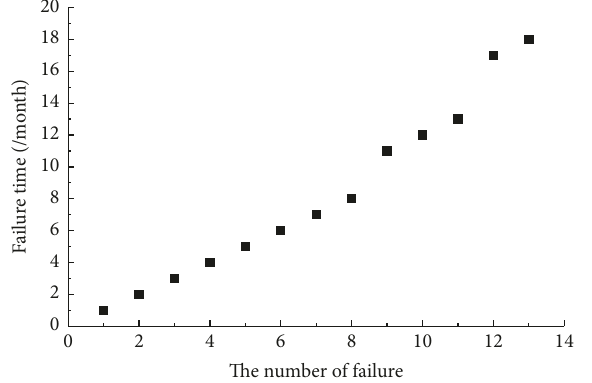
Figure 4: The historical data of the year 2009 of low-voltage switchgear.